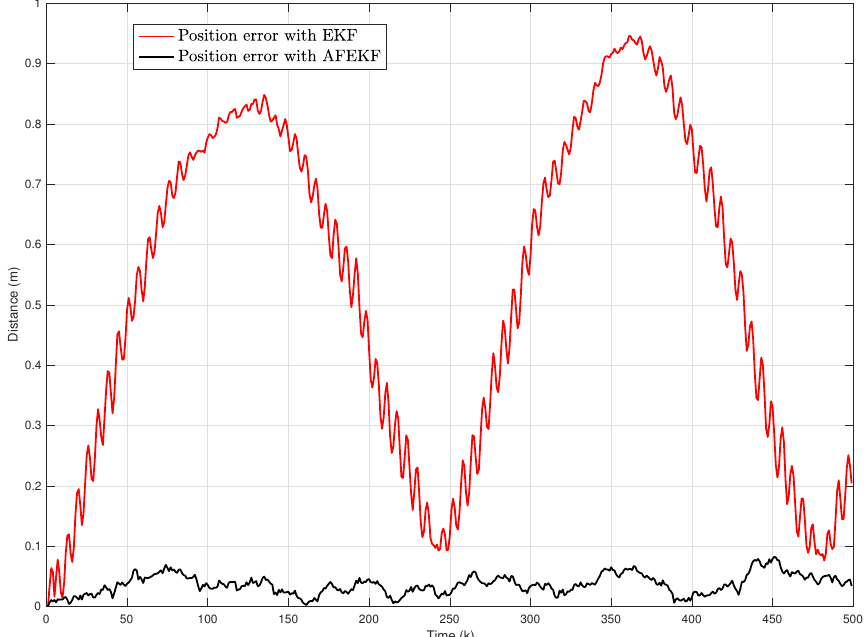
Figure 12. Robot’s position errors under